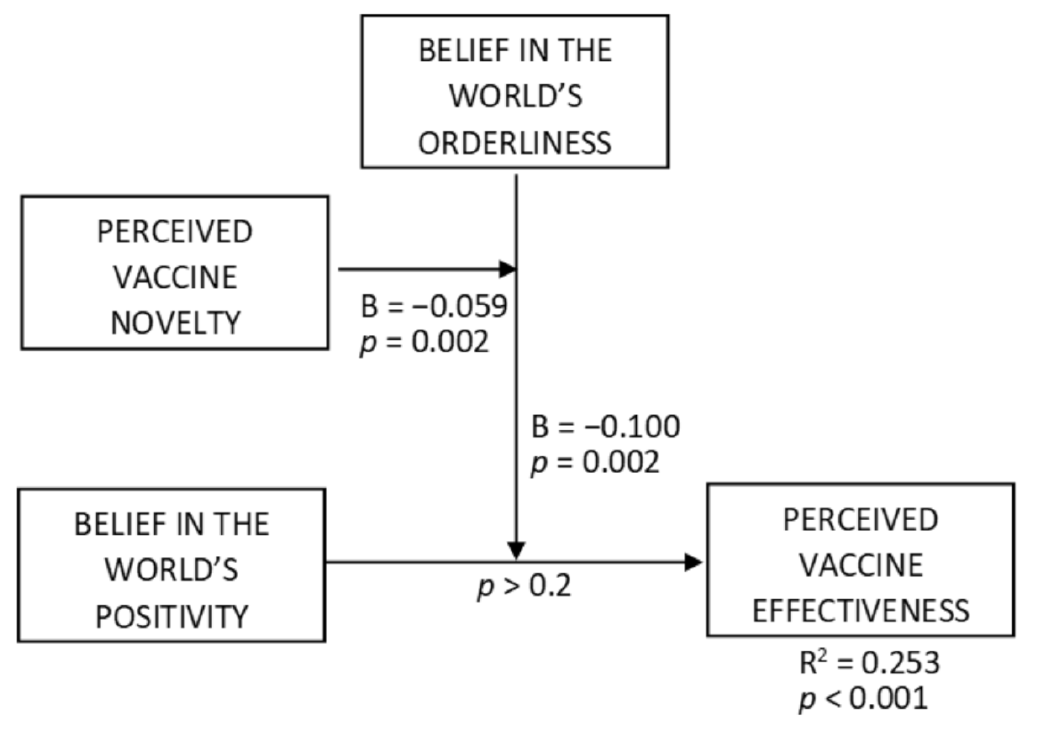
Figure 6. Moderated moderation effect of perceived vaccine novelty and belief in the world’s orderli- ness on the relationship between belief in the world’s positivity and perceived vaccine